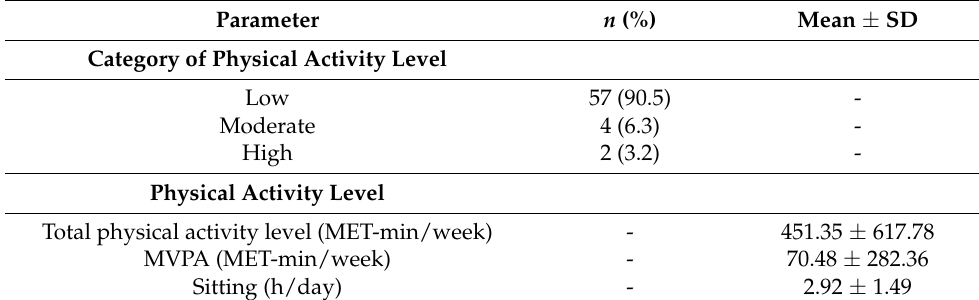
Table 5. Status of physical activity based on the IPAQ ( n = 63).